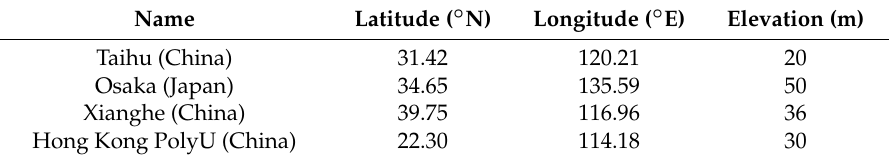
Table 1. Information about the selected Aerosol Robotic Network (AERONET)